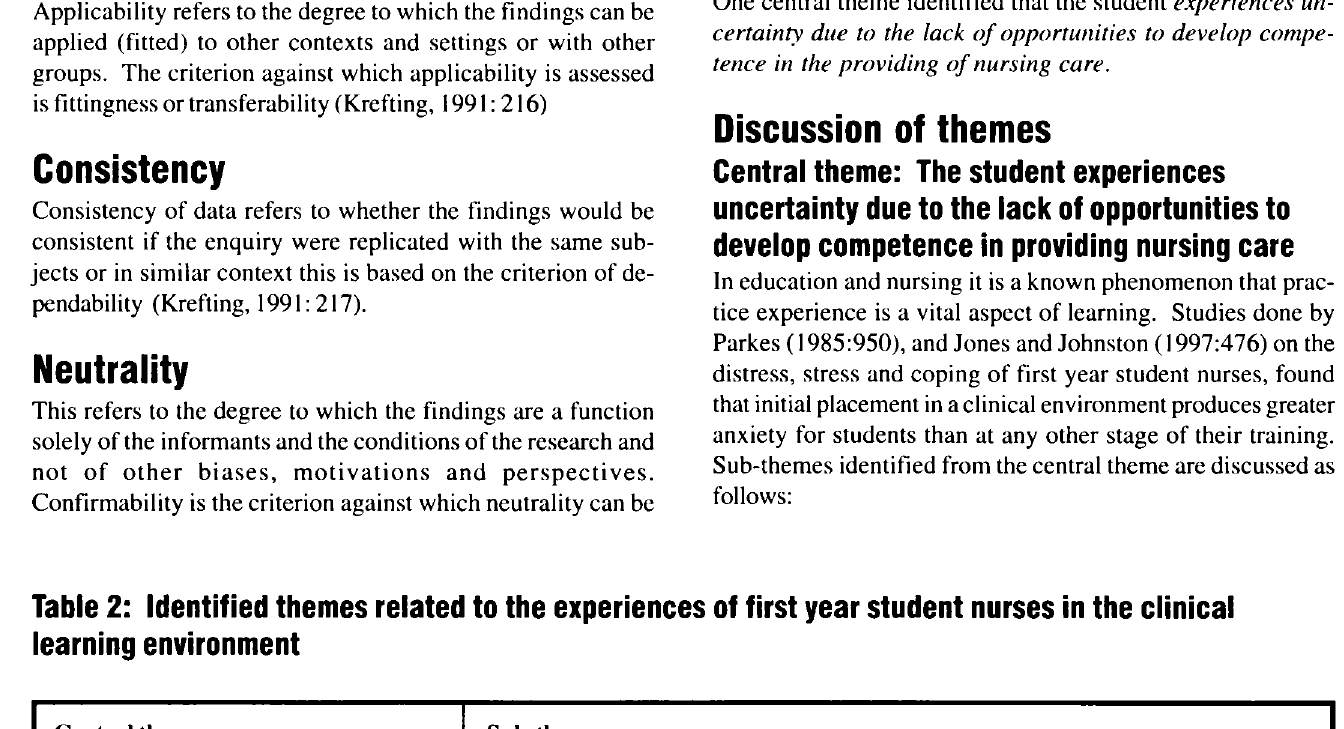
Table 2: Identified themes related to the experiences of first year student nurses in the clinical learning